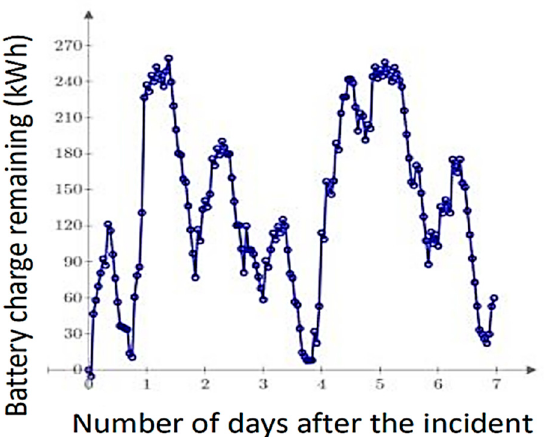
Figure 13. Monte Carlo simulation result: A time-series plot of the total battery charge remaining in the facilities supported by SEVs.